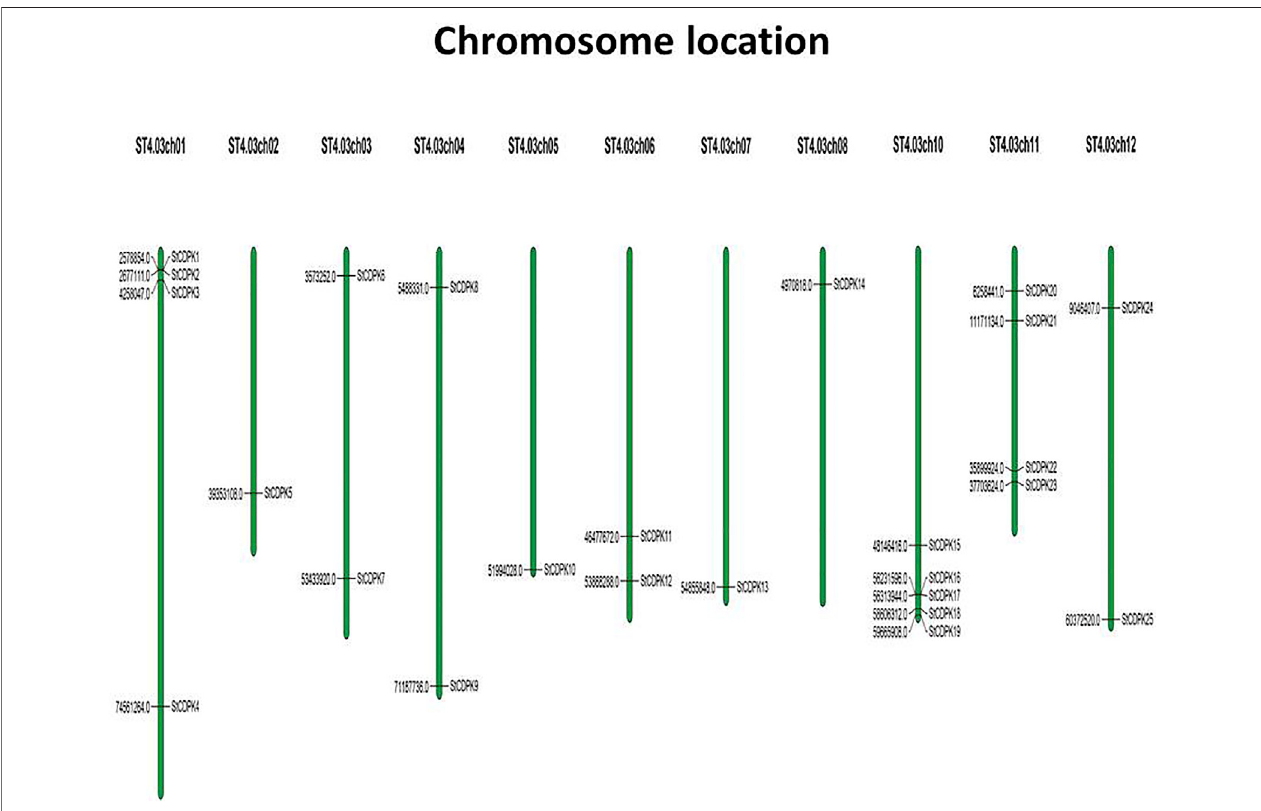
FIGURE1| Chromosomaldistributionof StCDPK genesinpotatogenome.Thegenesweredistributedonelevenchromosomeswiththeirnumbersshownontop. The black thin lines across the chromosomes indicate the exact location of the speci fi c gene.